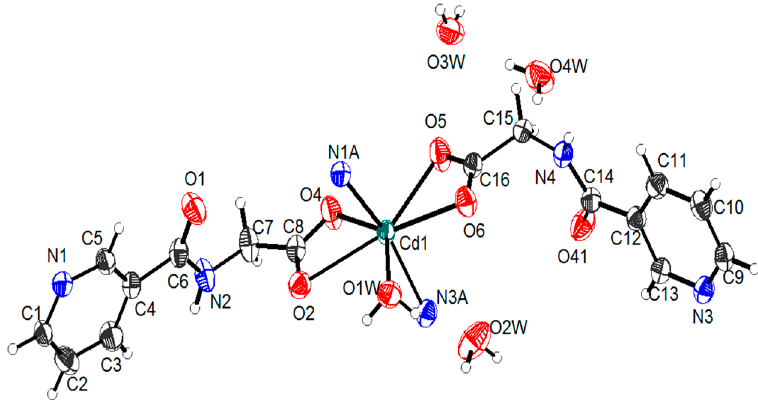
Figure 1. The coordination environment of the Cd(II) ion.